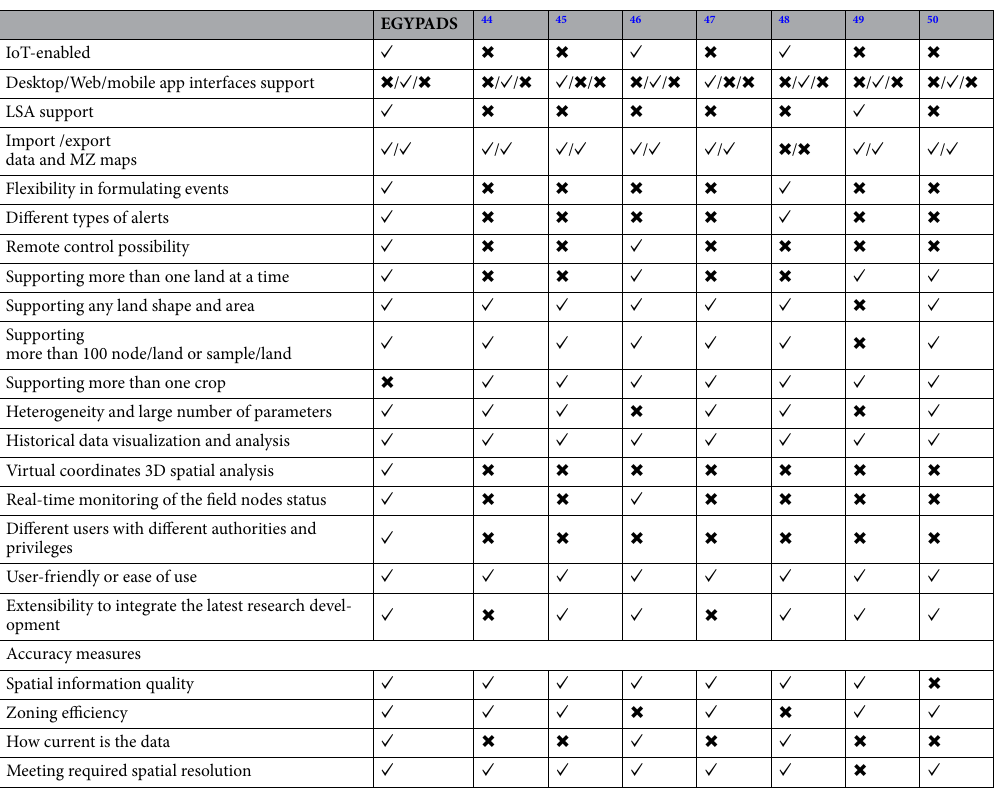
Table 1. Comparison between EGYPADS and MZs delineation and spatial analysis software